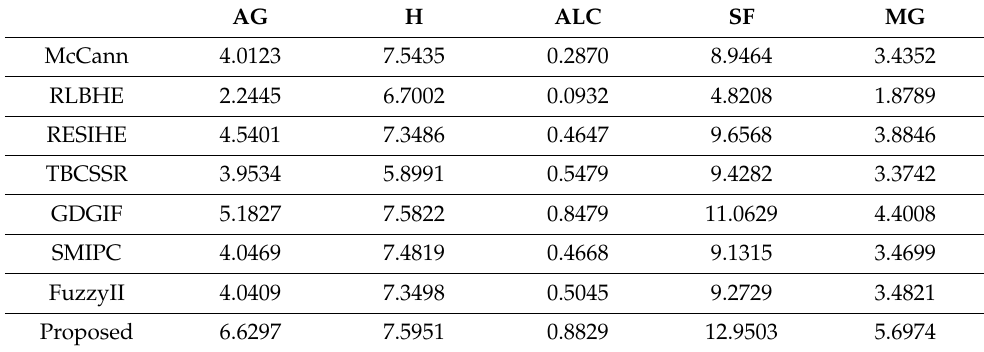
Table 3. The metric data of eight methods on X-ray image 3.